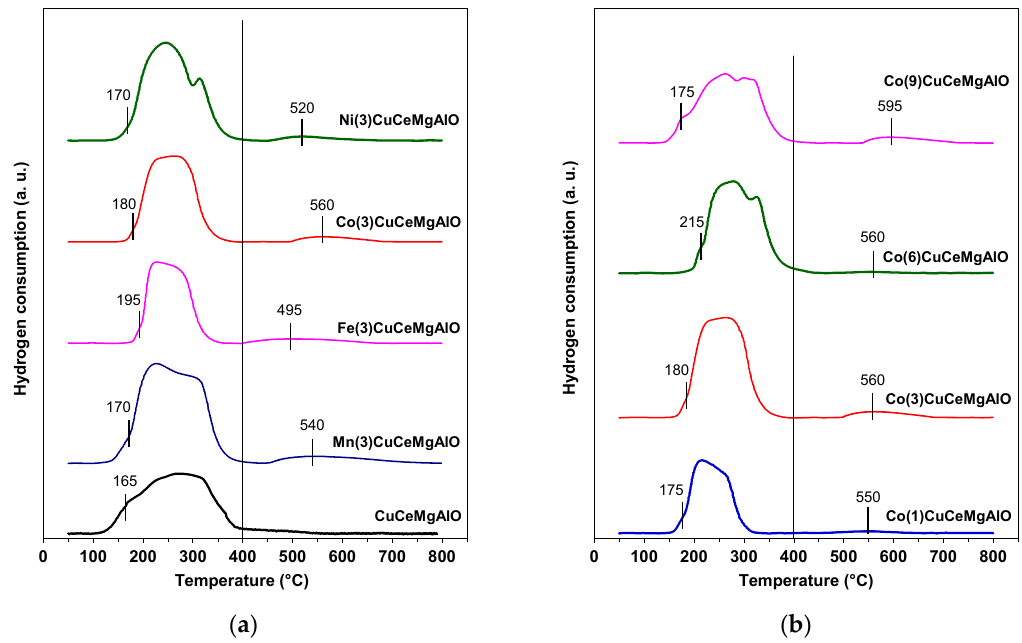
Figure 9. H 2 -TPR profiles of ( a ) CuCeMgAlO and M(3)CuCeMgAlO and ( b ) Co(x)CuCeMgAlO mixed oxides. Table 6. Hydrogen consumptions in the H 2 -TPR experiments.